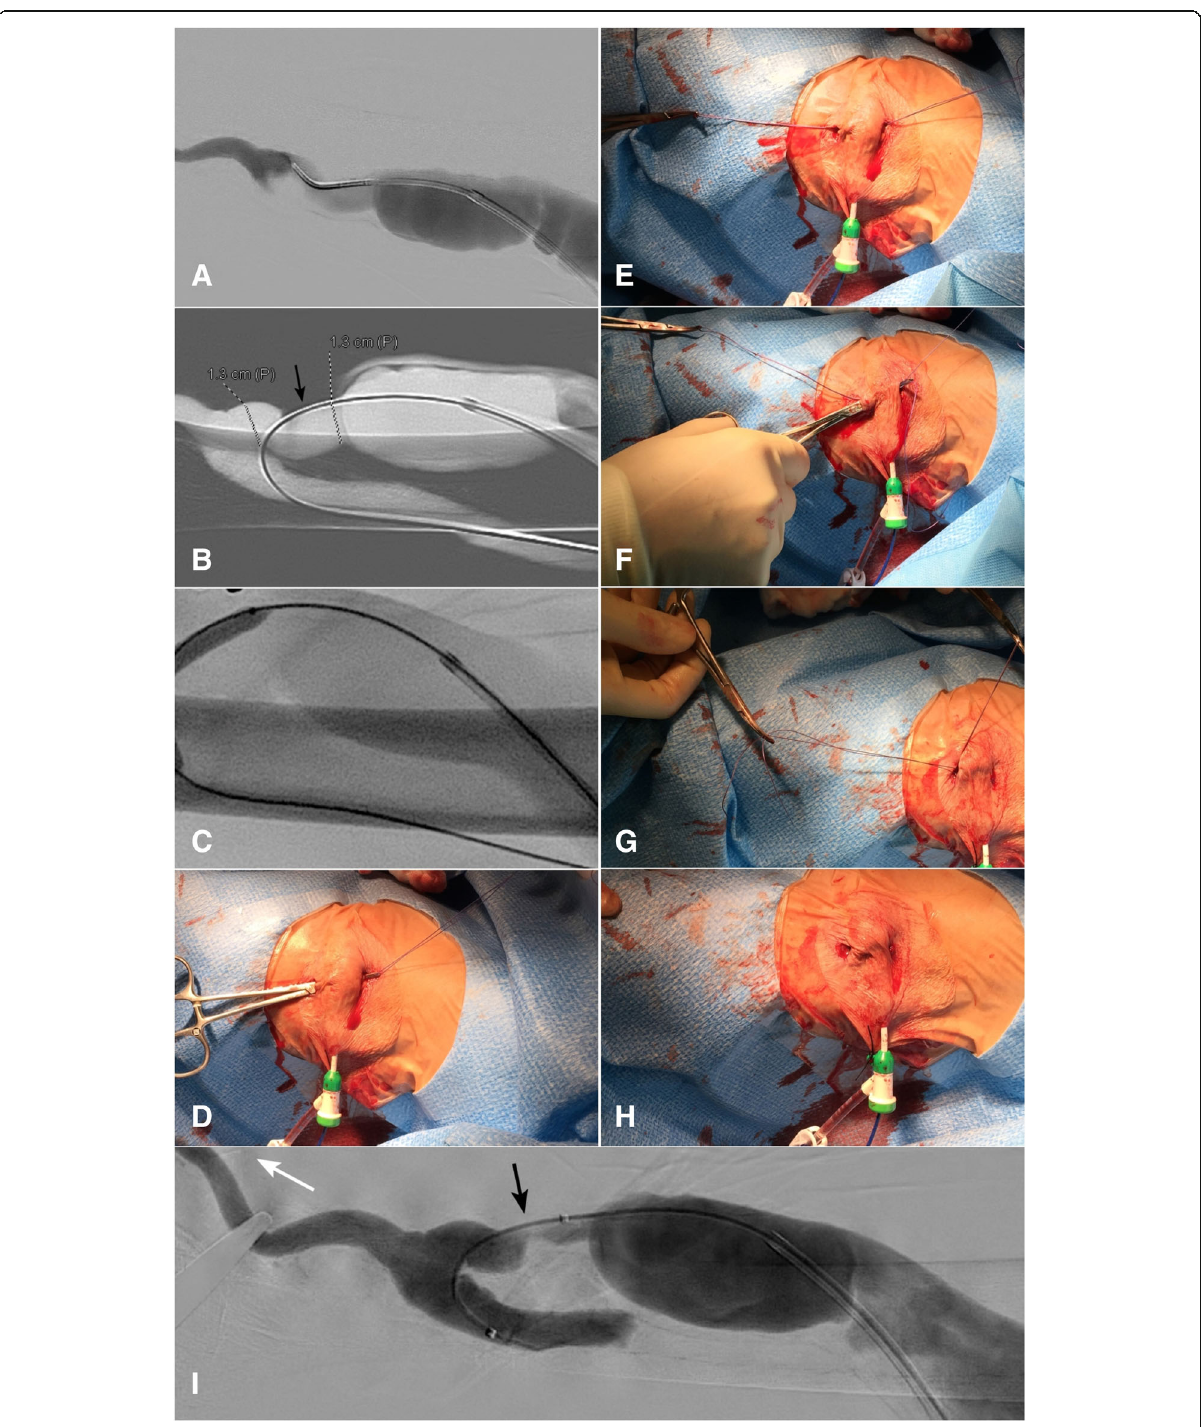
Fig. 1 a Retrograde percutaneous access was obtained through the venous outflow limb of the brachiocephalic AVF and a 6-French sheath was placed. b A guidewire is negotiated across the anastomosis retrogradely into the inflow brachial artery and the juxta-anastomotic venous outflow limb diameter is measured at 13 mm (arrow). c Following this, a 5 × 40 mm angioplasty balloon was inflated to nominal pressure and ( d ) blunt dissection was performed carefully on either side of the venous outflow limb. e-h The venous outflow limb was stenosed to the profile of the inflated balloon using a constraining 2 – 0 suture. i Completion fistulogram showing stenosis in the outflow vein (black arrow) and improvement in perfusion of the brachial artery distal to the anastomosis (white arrow) as well as to the